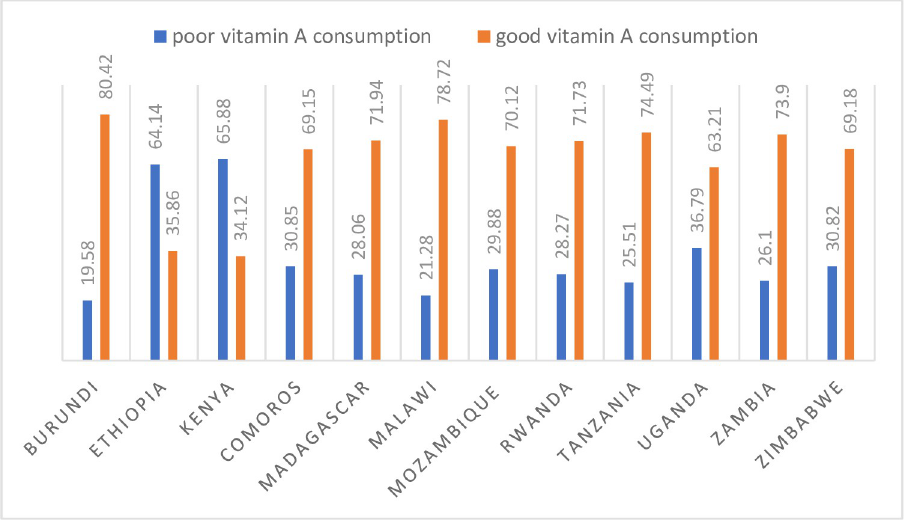
Fig 1. The proportion of vitamin consumption in the 12 East Africa Countries from a recent Demographic and Health survey from 2008 to 2017.